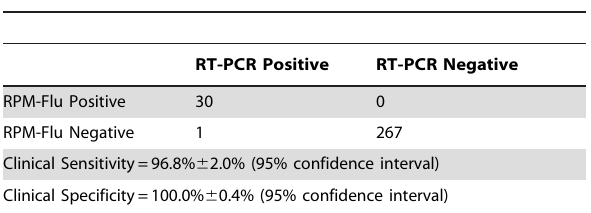
Table 3. Clinical sensitivity and clinical specificity of RPM-Flu for detection and identification of type A human influenza virus.